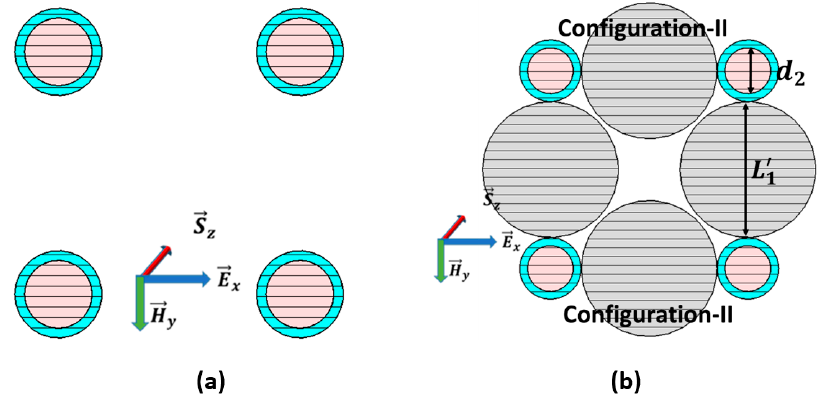
Figure 9a,b enlightens the SCS and ACS of the model I, where (a) reports the maxi- mum 12.85 × 10 (cid:2869)(cid:2868) nm (cid:2870) for model-I at the frequency (cid:1858) (cid:3042) = 600.0539 THz , whereas the minimum of ACS for model-I is 7 × 10 (cid:2872) nm (cid:2870) below the background values, as conveyed in (b). Similarly, the electric field in Figure 9c for model-I is 41783 V/m, and its current den- sity is 7.6 × 10 (cid:2876) A/m (cid:2870) at the resonance condition (cid:1858) (cid:3042) = 600.0539 THz . From Figure 9e for the model I, the XY-cut plane view reports 4.54 × 10 (cid:2873) VA/m (cid:2870) power flow, where the power flow for this model generates from the centers of CNPs and is scattered in all directions. The far-field pattern in Figure 9f reports 119 dBnm (cid:2870) RCS for model I and supports the power flow pattern.